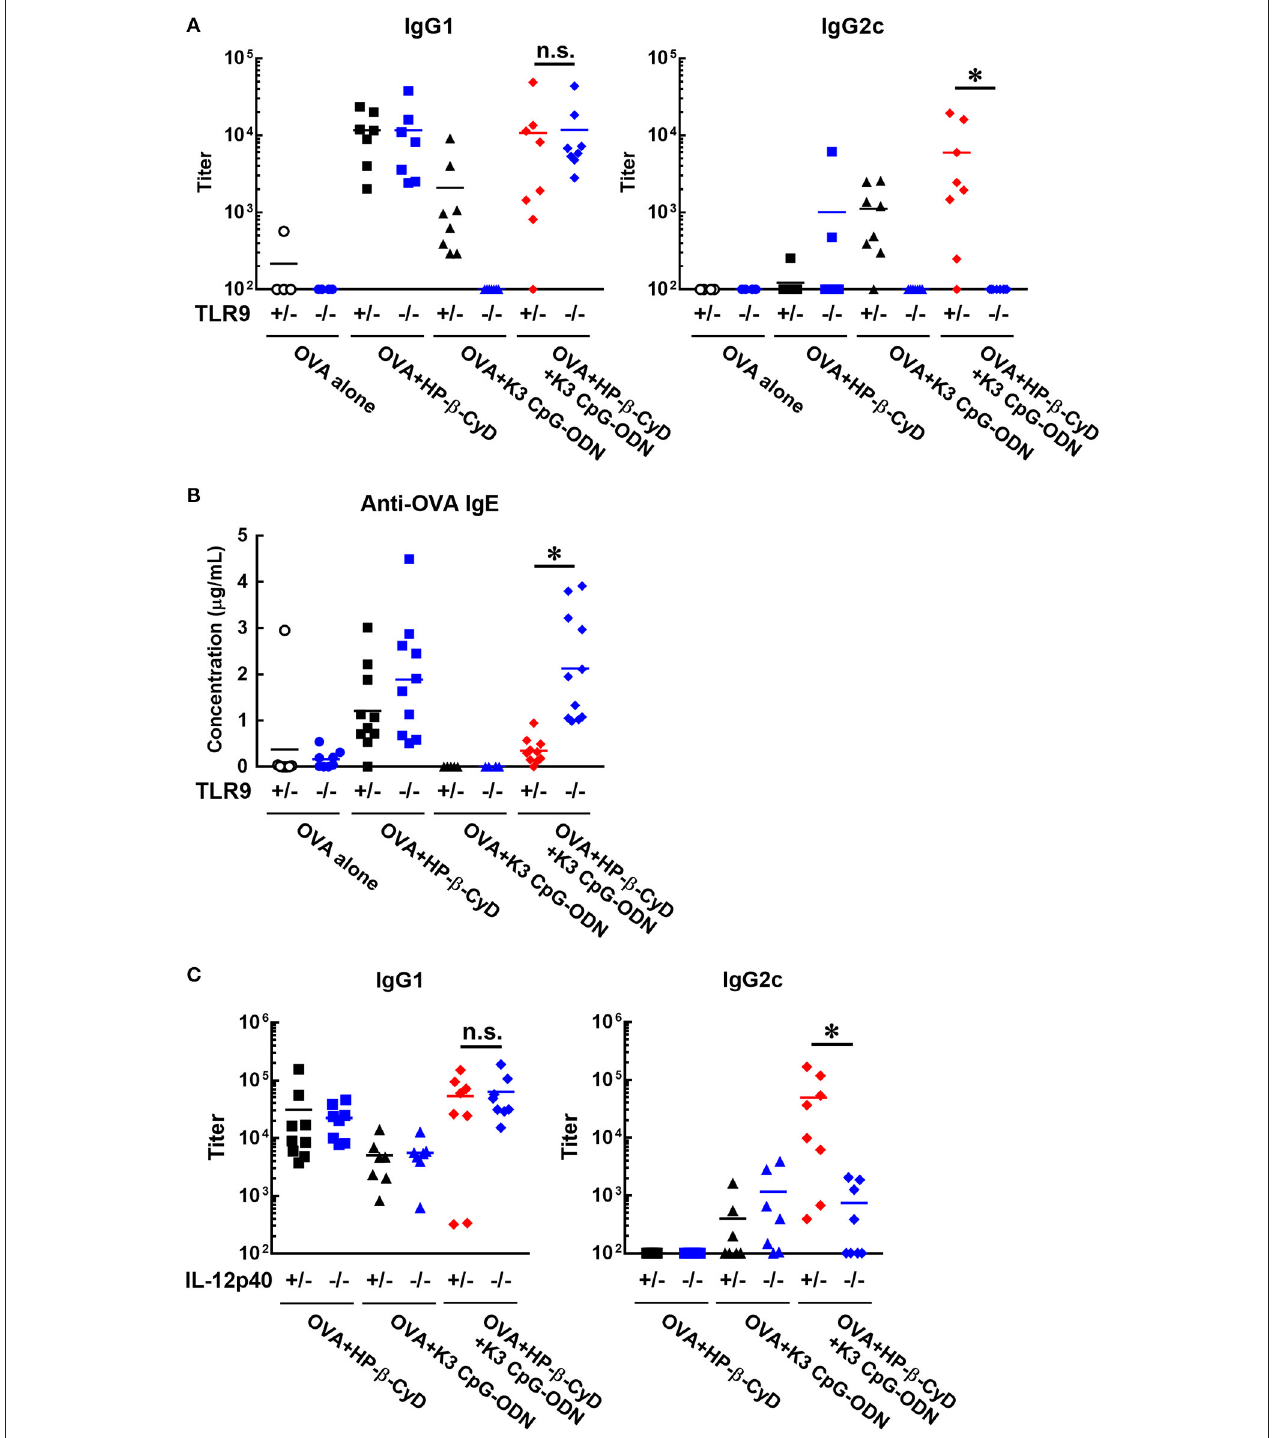
FIGURE 4 | Induction of type-1 immune responses by HP- β -CyD and K3 CpG-ODN is dependent on TLR9-mediated signaling and the production of IL-12p40. (A–C) C57BL/6 mice ( A,B ; Tlr9 + / − or Tlr9 − / − , C ; Il-12p40 + / − or Il-12p40 − / − ) were inoculated with 3 µ g of OVA in solution containing 30% HP- β -CyD and 10 µ g of K3 CpG-ODN into the base of the tail on day 0 and 14. Blood was collected 7 days after the boost. Anti-OVA IgG1, IgG2c and IgE were determined by ELISA. Each dot represents an individual mouse ( A ; n = 4–8, B ; n = 4–11, C ; n = 7–9 per group in two independent experiments, blue; gene deficient mice). * p < 0.05 (one-way ANOVA with Bonferroni’s multiple comparison